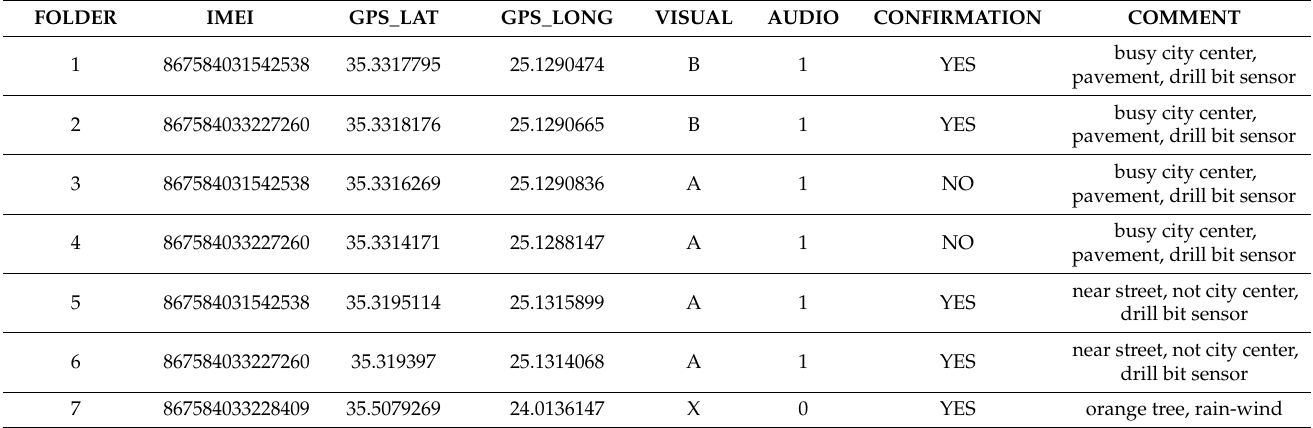
Table A1. Adam optimizer (learn_rate = 0.001, decay = 1 × 10 − 6 ).